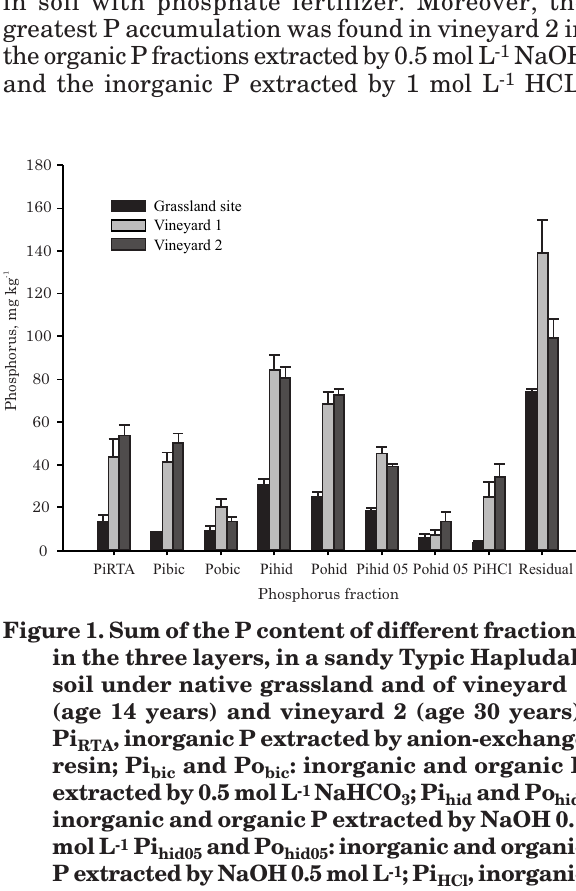
Table 4. Inorganic P extracted by 1 mol L -1 HCL and residual P fractions in a sandy Typic Hapludalf soil of a grassland site, vineyard 1 (age 14 years) and vineyard 2 (age 30 years), in three layers